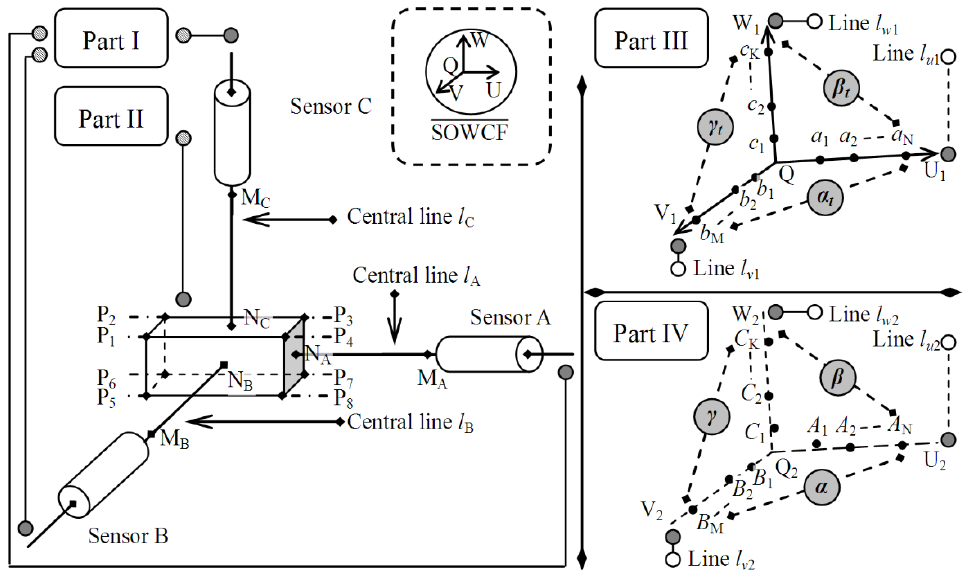
Figure 5. The effects of the poses of the system components on the motion trajectory orthogonality estimation. The error sources include the rotation angles of the sensors in the Part I, and the rotation angles of the standard gauge block in the Part II. The standard gauge block moves at the positions located on the three initial motion trajectory lines in the Part III. And the simulated motion trajectory lines are obtained under the rotations of the sensors and the standard gauge block.